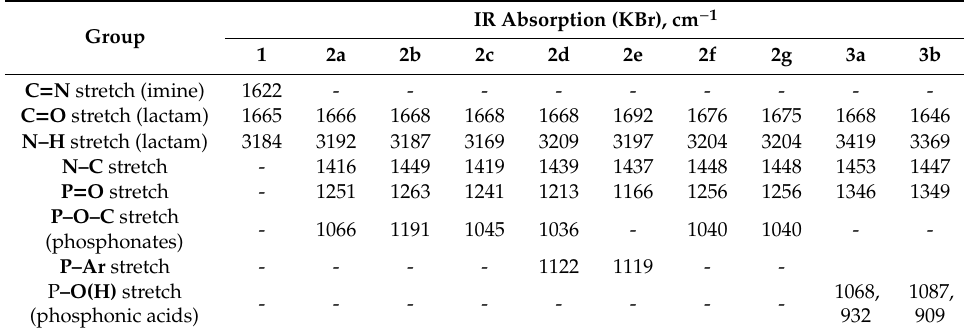
Table 1. The IR absorption of important functional